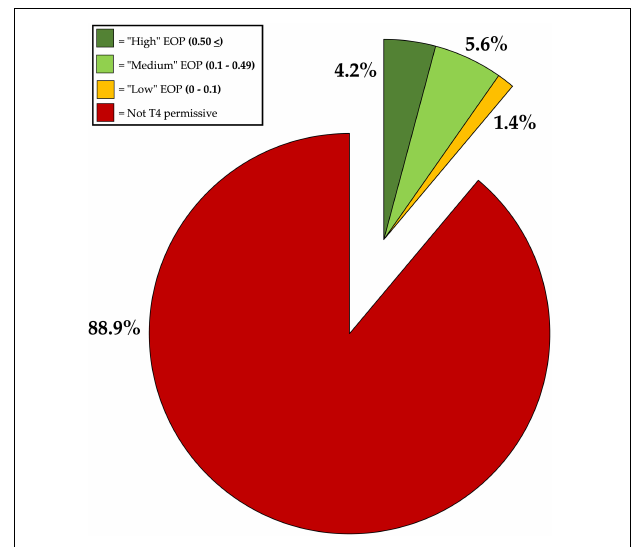
FIGURE 3 | Ranked efficiency of plating (EOP) evaluations for phage T4 against Escherichia coli reference collection (ECOR) Library, using E coli DH5 α as a reference